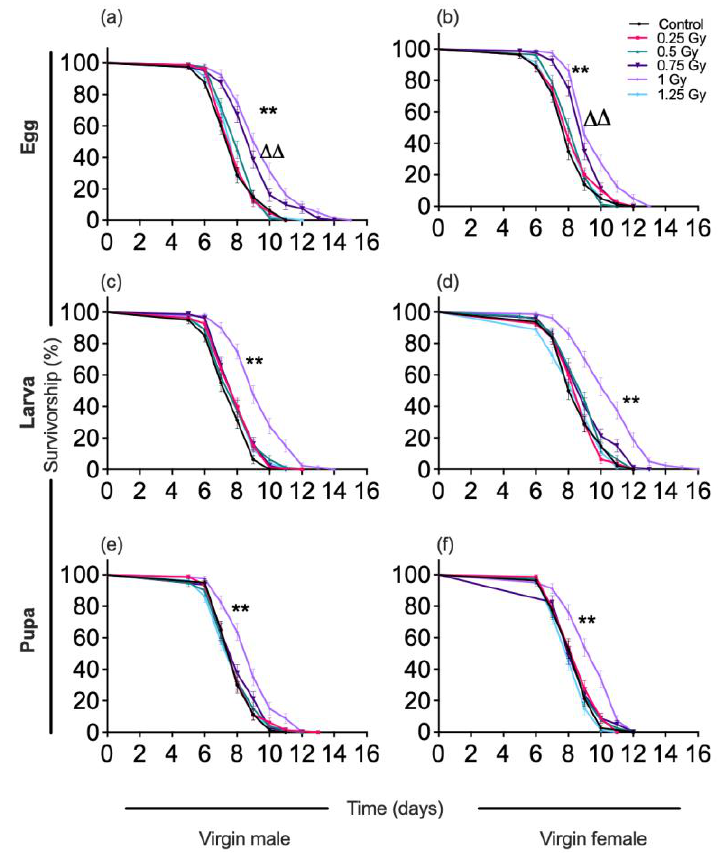
Means followed by the same letters within a row are not significantly different at p < 0.05 level. One-way ANOVA followed by Tukey’s multiple comparisons ( p < 0.05) was considered significant. n = 10; The average longevity of ten insects (virgin and mated) from each cohort was computed as one replicate.